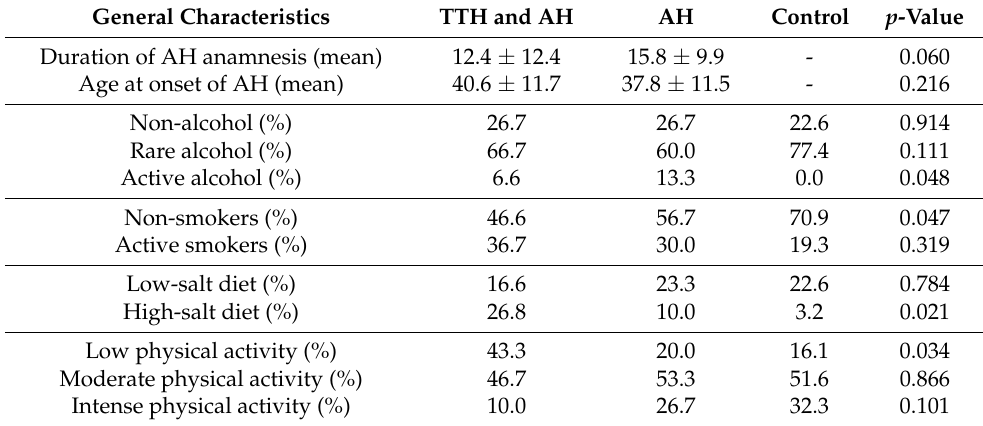
Table 1. General characteristics of the cases (groups 1 and 2) and control (group 3).